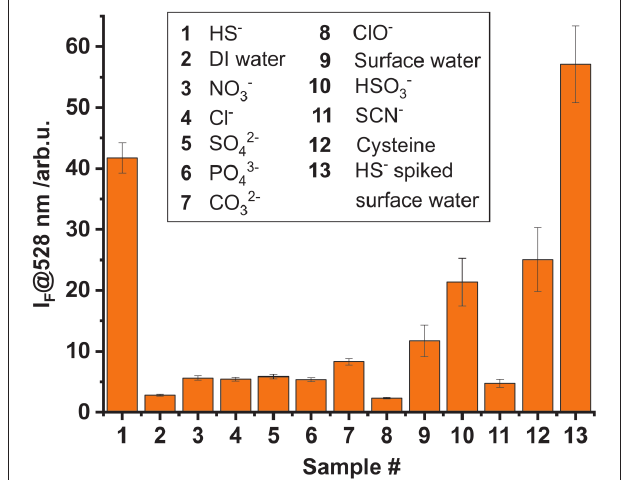
FIGURE 6 | Cross-reactivity study investigating the fluorescence response of complex 1 (5 × 10 − 8 mmol per well) adsorbed on hydrogel D4 upon addition of 200 µ L of 0.3mM aqueous solutions of different anions and thiols. The incubation time was 1.5h. Sample 13 is surface water spiked with a similar amount of HS − than sample 1 .